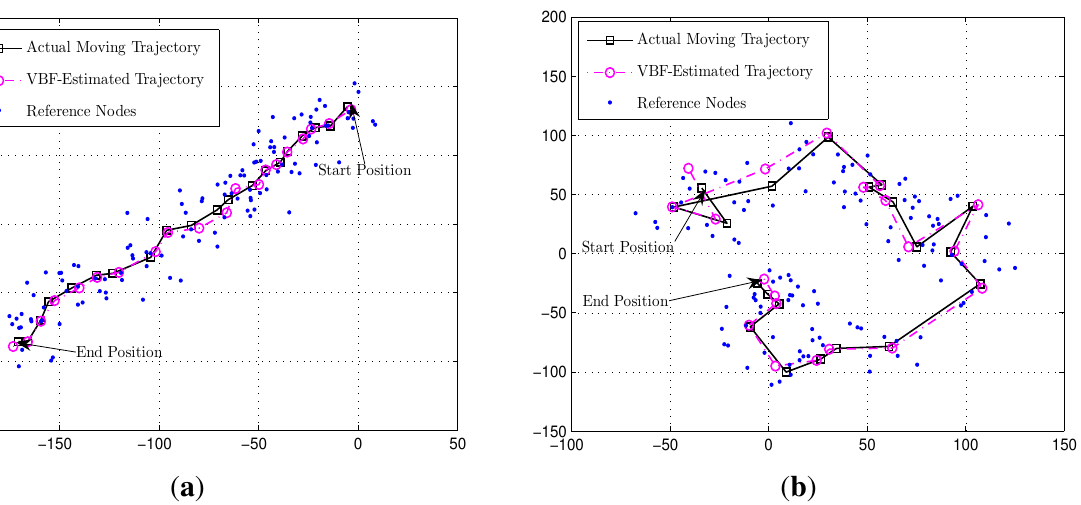
Figure 3. Illustrates of the variational Bayesian filtering (VBF) scheme for a mobile target. In both subfigures, the solid line with squares denotes the actual trajectory and the doted line with circles denotes the trajectory estimated by the VBF scheme. In both cases, some system parameters are set to be Σ = 1 / 5 I , β = 10 , W = 1 / 1500 , ψ = 80 , M parameters are specified in the two subfigures, respectively. Note that the units in both x -axis and y -axis are meters. ( a ) The mobile target moves in a directional manner, where υ = 10 I [m / s] , U = 1 / 10 I and V = 1 / 10 I . In this case, the achieved RMSEs are: e G = 4 . 05 and G = 3 . 24 ; ( b ) The mobile target moves without a directional trend, MLE BF where υ = 0 [m / s] , U = 1 / 900 I and V = 1 / 10 I . In this case, the achieved RMSEs are: e = 4 . 63 , G = 4 . 59 and G = 4 . 55 VBF MLE BF